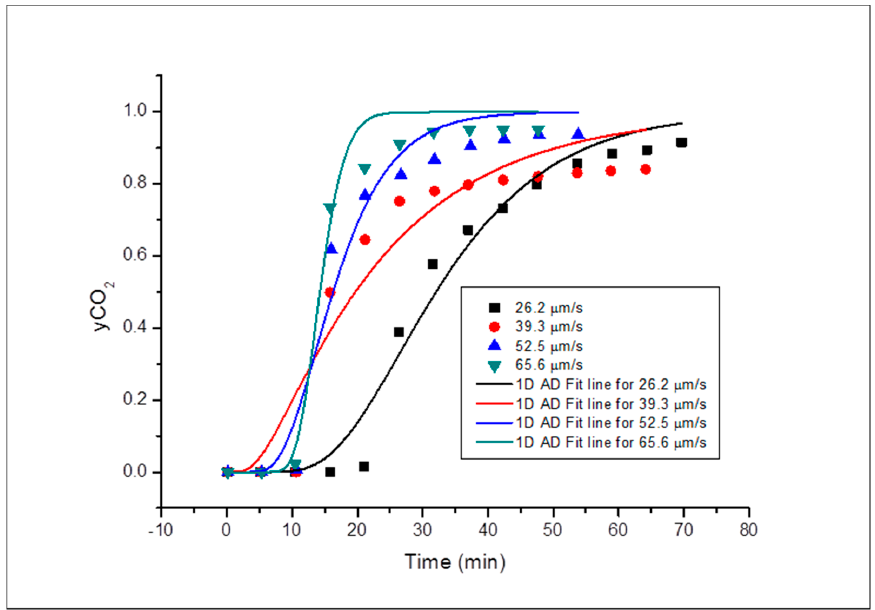
Figure 6. Concentration profile for all Buff Berea runs in vertical orientation.